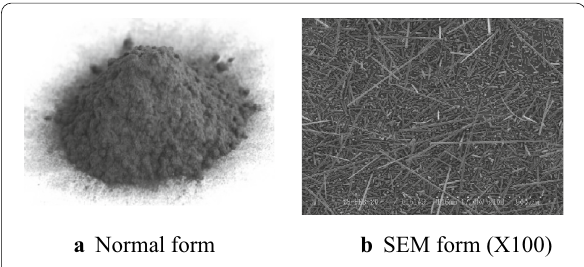
Fig. 2 Appearance of milled carbon fiber.